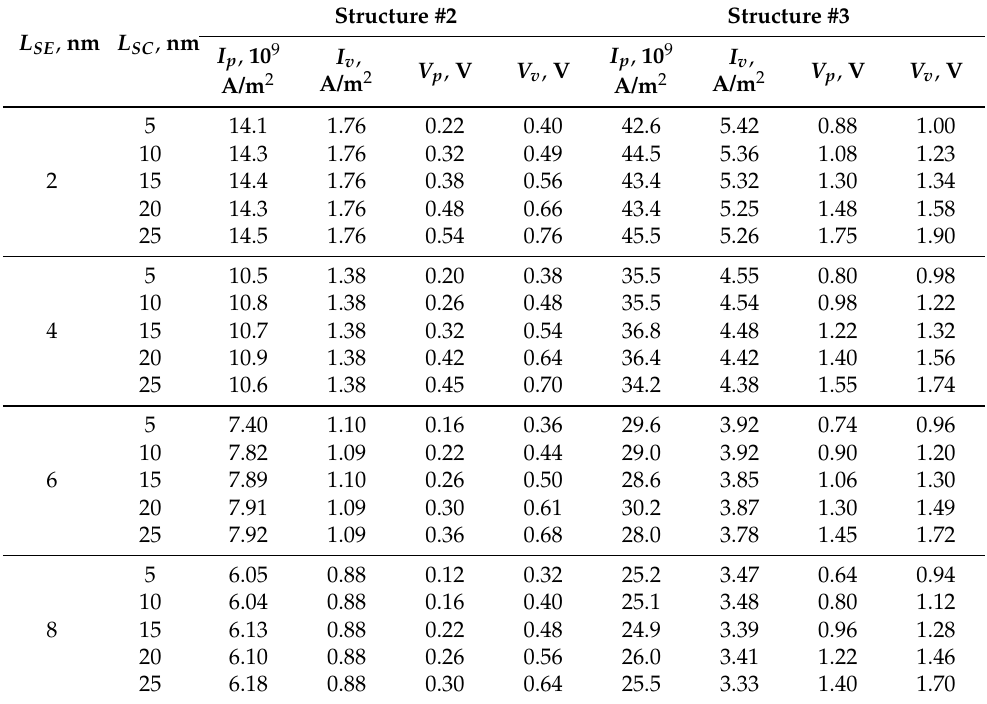
Table 3. The values of peak current I p , valley current I v , peak voltage V p , and valley voltage V v for different thicknesses of spacer emitter and spacer collector. The results are presented for the resonant tunneling Structures #2 and